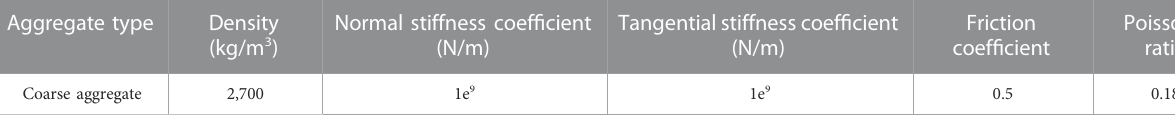
TABLE 8 Linear stiffness contact parameters of the aggregate model.